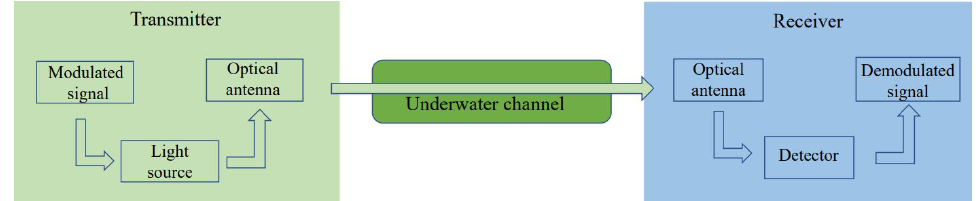
Figure 1. Schematic of underwater wireless optical communication system